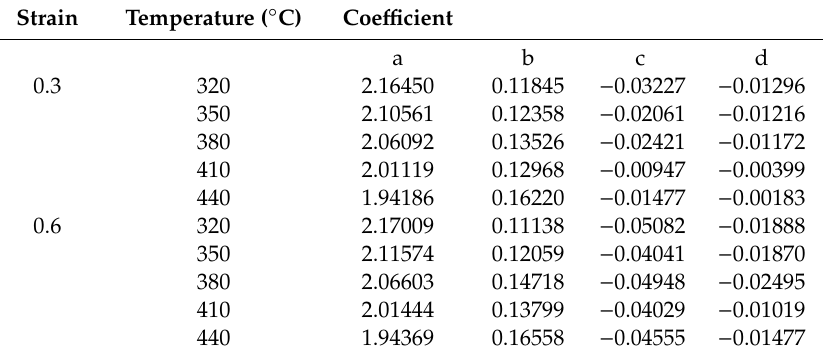
Table 3. Polynomial fitting coe ffi cients in Equation (14) for Al-Zn-Mg-Cu alloy. Strain Temperature ( ◦ C) Coe ffi